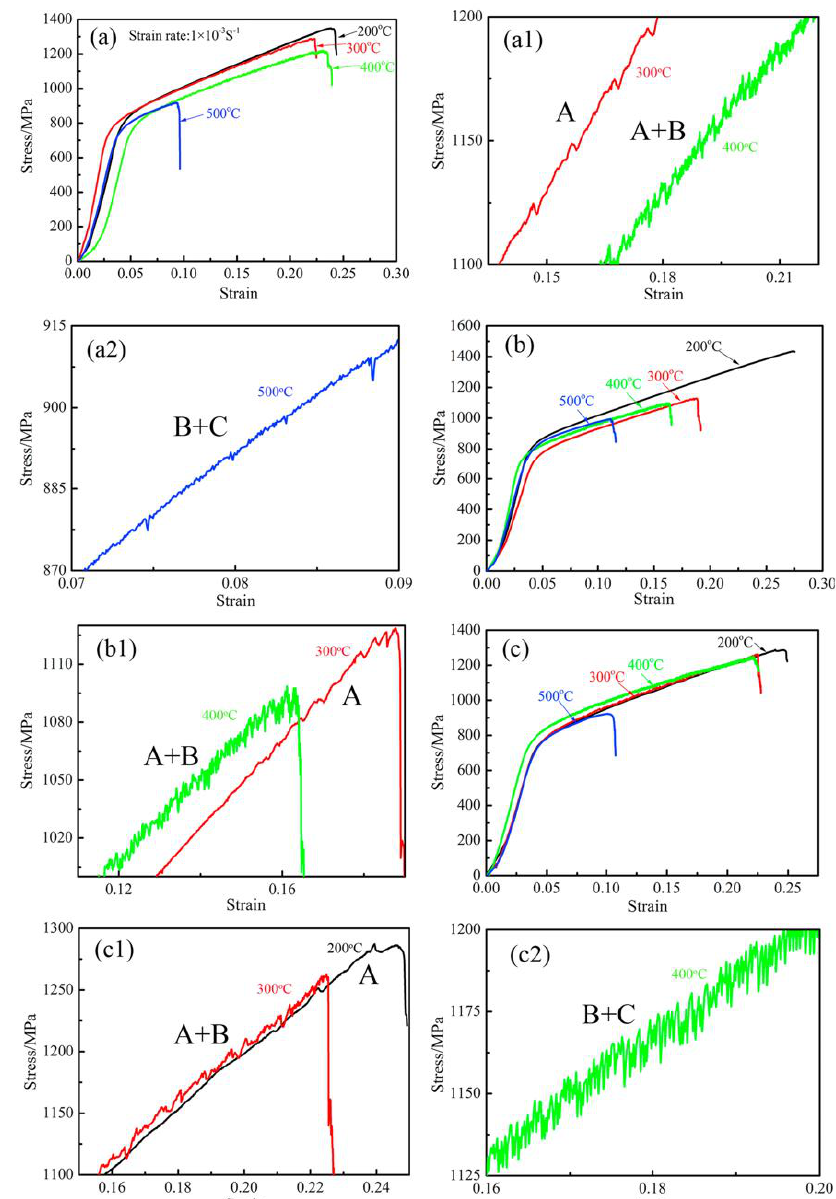
Figure 29. The tensile true stress–strain curves for the Al 0.5 CoCrFeNi HEA tested at temperatures of 200–500 °C and strain rates of ( a ) 10 −3 s −1 where selected regions of the corresponding dynamic strain aging (DSA) curve are in ( a1 ), ( a2 ), and ( b ) 5 × 10 −4 s −1 where selected regions of the corresponding DSA curve are in ( b1 ), and ( c ) 10 −4 s −1 where selected regions of the corresponding DSA curve are in ( c1 ) and ( c2 ) (reproduced from Reference [94] with permission).